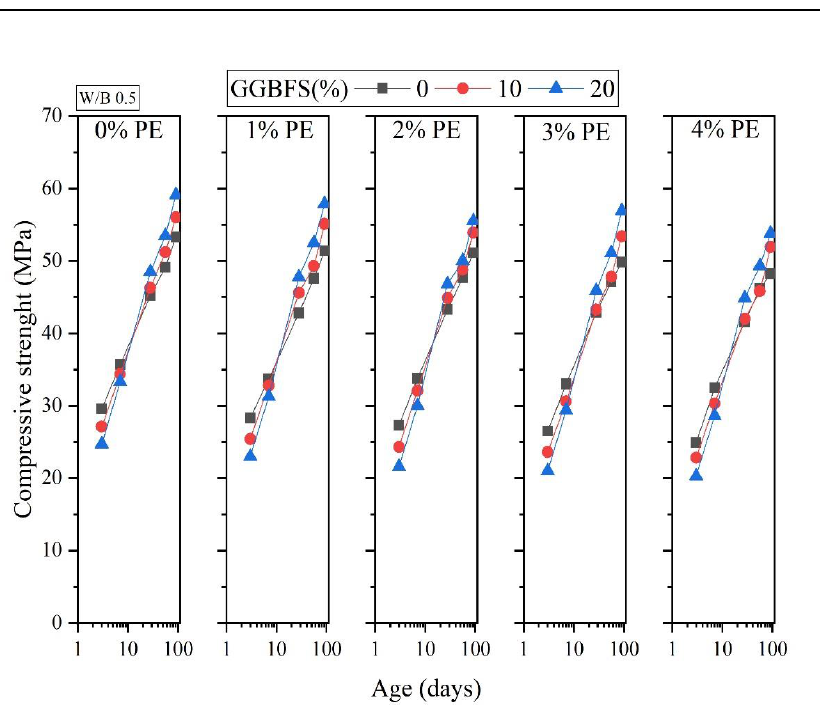
Figure 6. Compressive strength of cement mortars with the addition of different ratios of waste PE and GGBFS replacement. Table 5. Compressive strength of cement mortars with the addition of different ratios of waste PE and GGBFS replacement (unit: MPa).